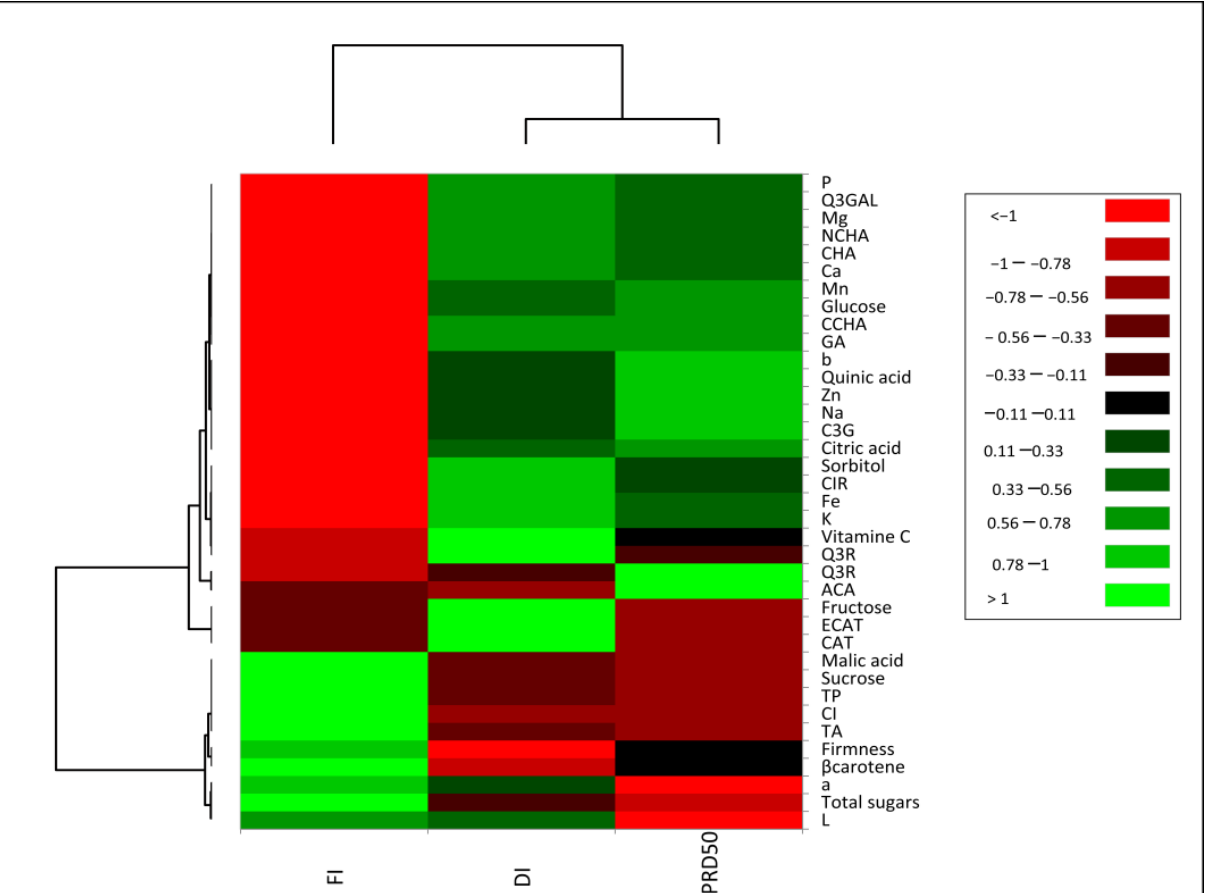
Figure 8. Heat map representation of Flordastar peach fruit quality traits grown under FI, DI and PRD 50 irrigation treatments.